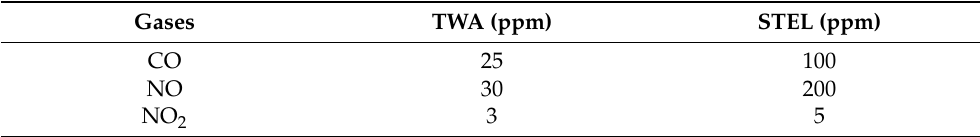
Table 1. Exposure limits for CO, NO and NO 2 [8].